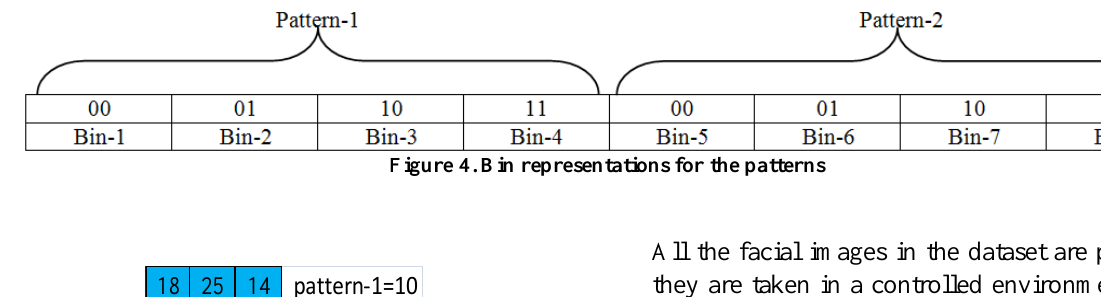
Figure 3. Single pixel representation using two separate patterns